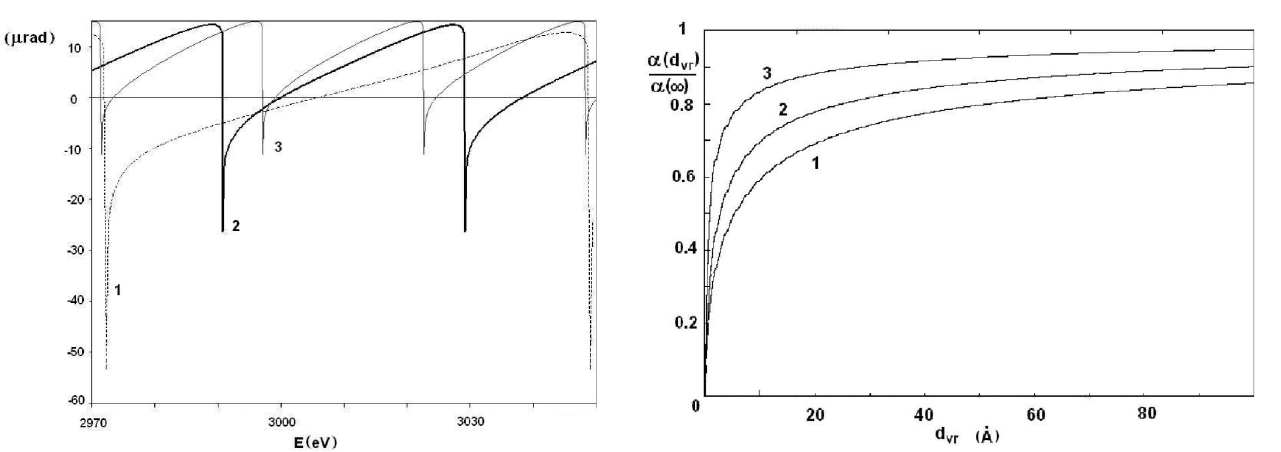
m.FIG. 4. The angle of volume reflection as a function of the transversal energy for the values of radius equal to 1 m, 2 m, and 3 m (1,2,3 curves,